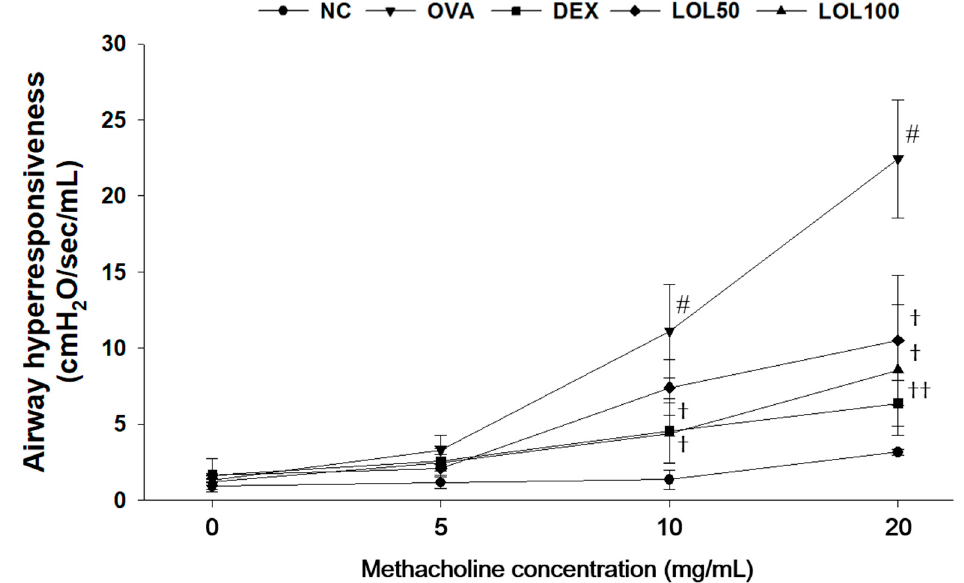
Figure 2. E ff ects of LOL on airway hyper-responsiveness in OVA-challenged asthma model. NC: normal Figure 2. Effects of LOL on airway hyper-responsiveness in OVA-challenged asthma model. NC: control mice; OVA: OVA-challenged mice; DEX: dexamethasone (3 mg / kg) + OVA-challenged mice; normal control mice; OVA: OVA-challenged mice; DEX: dexamethasone (3 mg/kg) + OVA-challenged LOL: LOL (50 or 100 mg / kg) + OVA-challenged mice. The values are expressed as the means ± SD mice; LOL: LOL (50 or 100 mg/kg) + OVA-challenged mice. The values are expressed as the means ± ( n = 7 / group). # p < 0.01, significantly di ff erent from NC group; † , †† p < 0.05, p < 0.01, significantly SD ( n = 7/group). # p < 0.01, significantly different from NC group; †, †† p < 0.05, p < 0.01, significantly di ff erent from OVA-challenged different from OVA-challenged group.